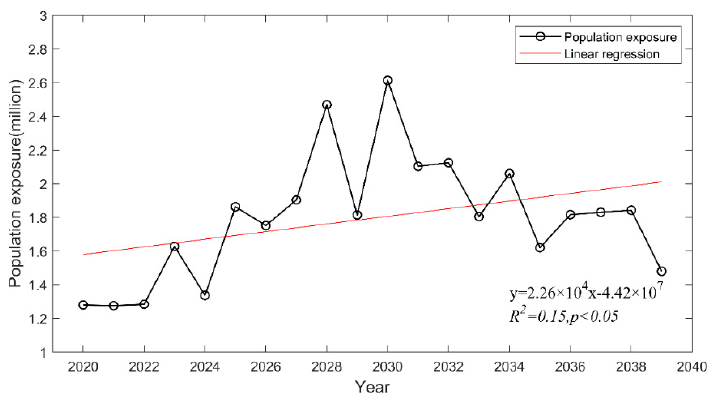
Figure 5. Annual population exposure to extreme precipitation events in the Loess Plateau under the 1.5 °C global warming scenario.